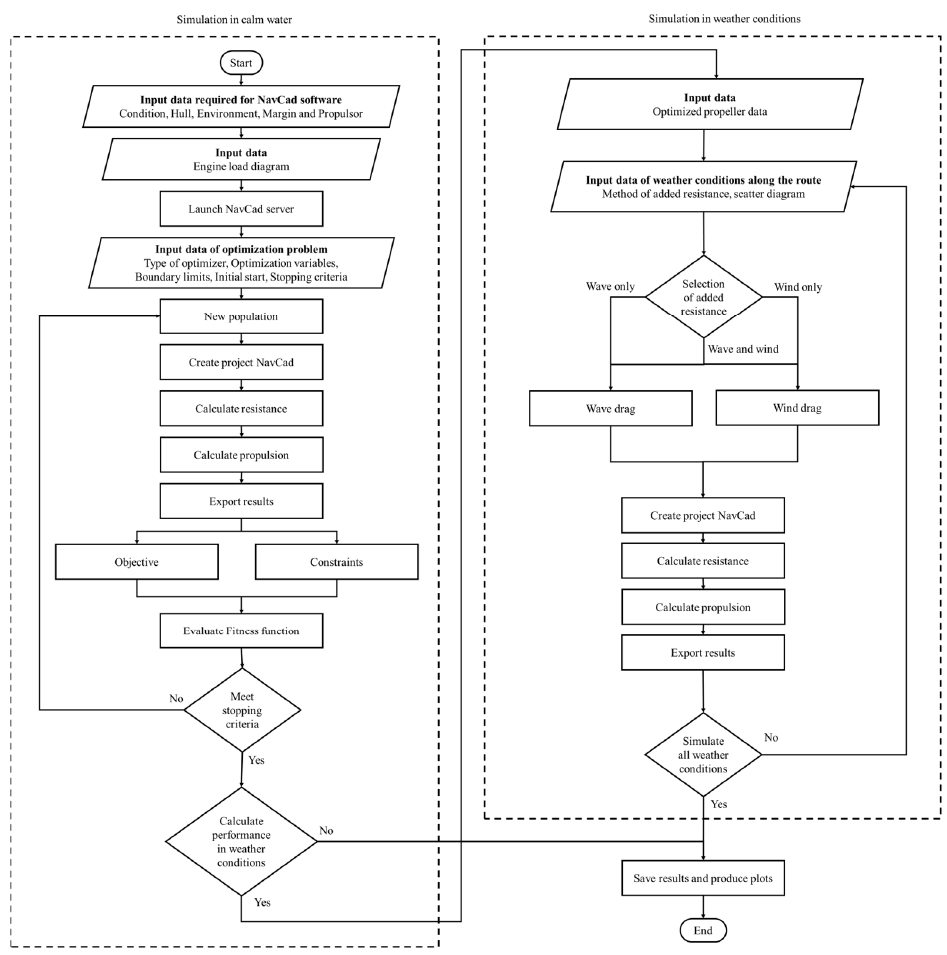
Figure 1. Schematic diagram of the simulation process in different weather conditions.